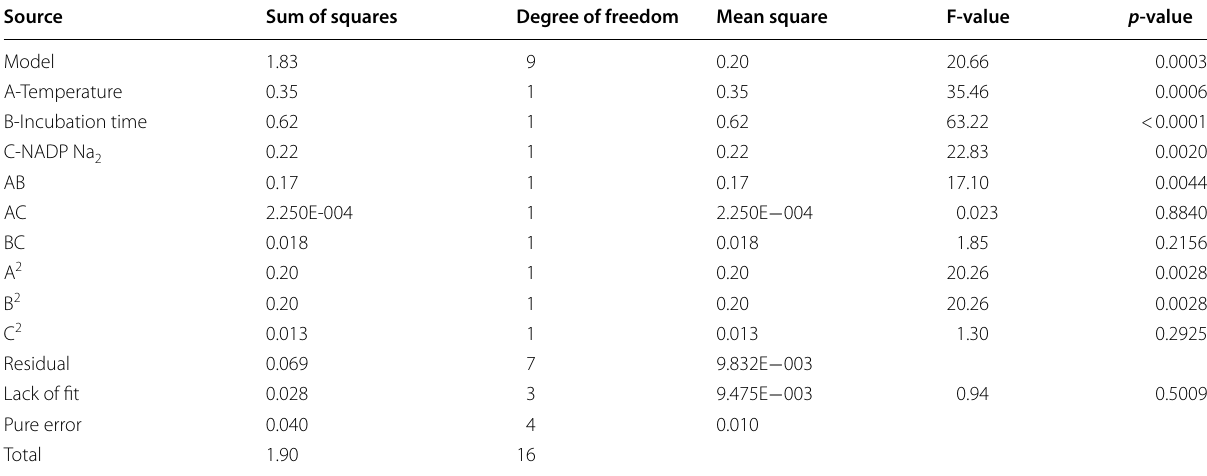
Table 2 Analysis of variance results of regression simulation